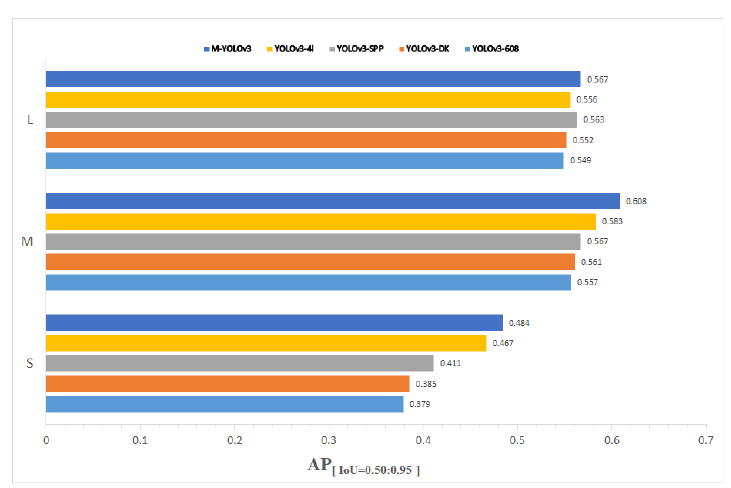
Figure 12. Plot of M-YOLOv3 versus other improved strategies on the TT100K dataset.